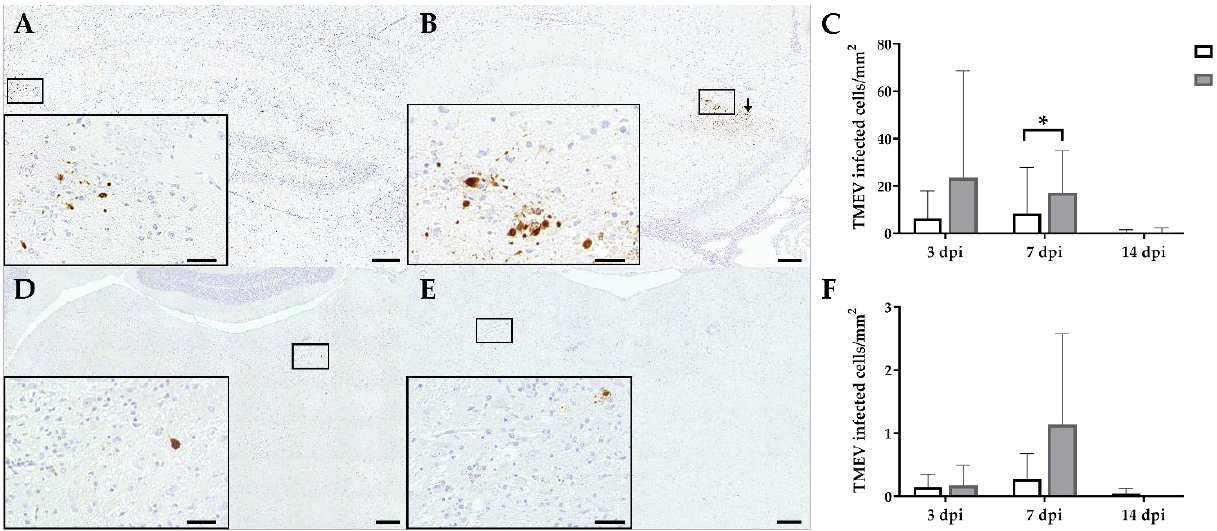
Figure 2. Quantification of Theiler‘s murine encephalomyelitis virus (TMEV)-infected cells in C57BL/6 wild-type (WT) mice and CARD9 −/− mice. TMEV-infected cells in the hippocampus of ( A ) a WT and ( B ) a CARD9 −/− mouse at 7 days post infection (dpi). ( B ) TMEV antigen (arrows) primarily in pyknotic hippocampal neurons of a CARD9 −/− mouse at 7 dpi. ( C ) Quantification of TMEV-infected cells in the hippocampus. TMEV-infected cells in the brainstem of ( D ) a WT and ( E ) a CARD9 −/− mouse at 7 dpi. ( F ) Quantification of TMEV-infected cells in the brainstem. ( A , B , D , E ) TMEV-specific immunohistochemistry. * Significant difference between WT and CARD9 −/− mice ( p ≤ 0.05; Mann–Whitney U -test). Three dpi: WT n = 10, CARD9 −/− n = 10; 7 dpi: WT n = 10, CARD9 −/− n = 9; 14 dpi: WT n = 10, CARD9 −/− n = 10. Data are displayed as mean with SD. Immunohistochemistry, scale bar: 100 µm ( A , B , D , E ) and 20 µm ( A , B , D , E ).